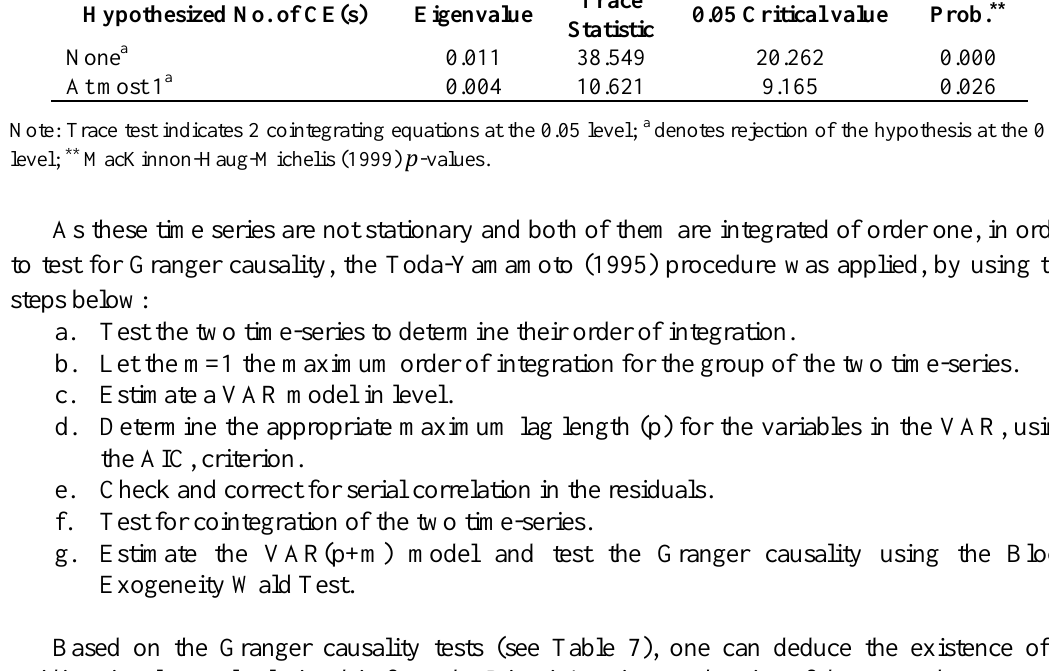
Table 6 : Johansen cointegration test results Unrestricted Cointegration Rank Test